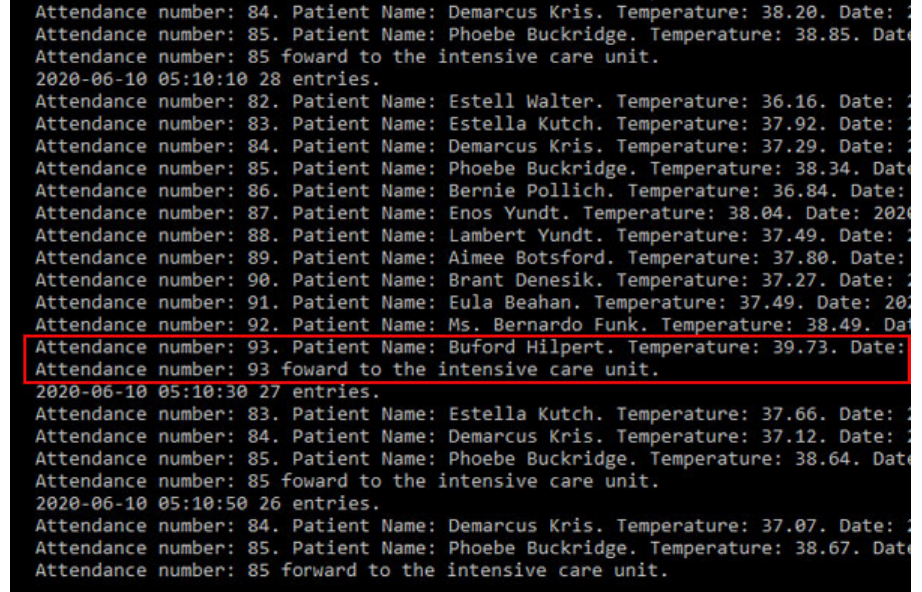
Figure 14. Patient registry simulating medical care